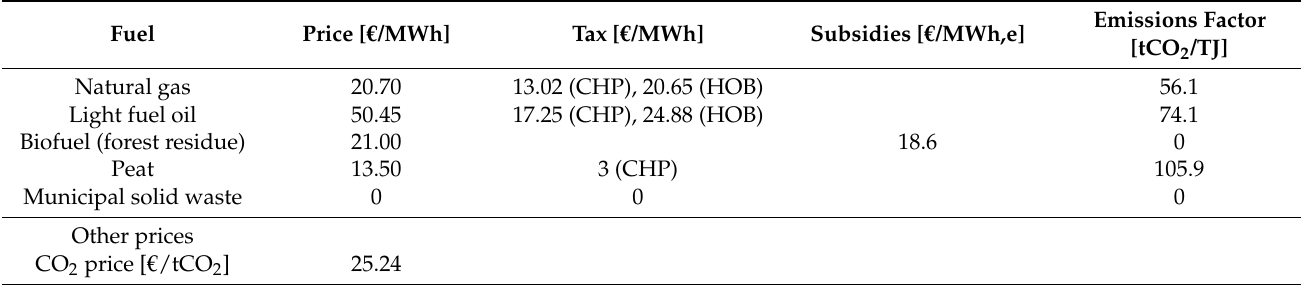
Table A2. Fuel and heat prices and taxes used in optimisations.